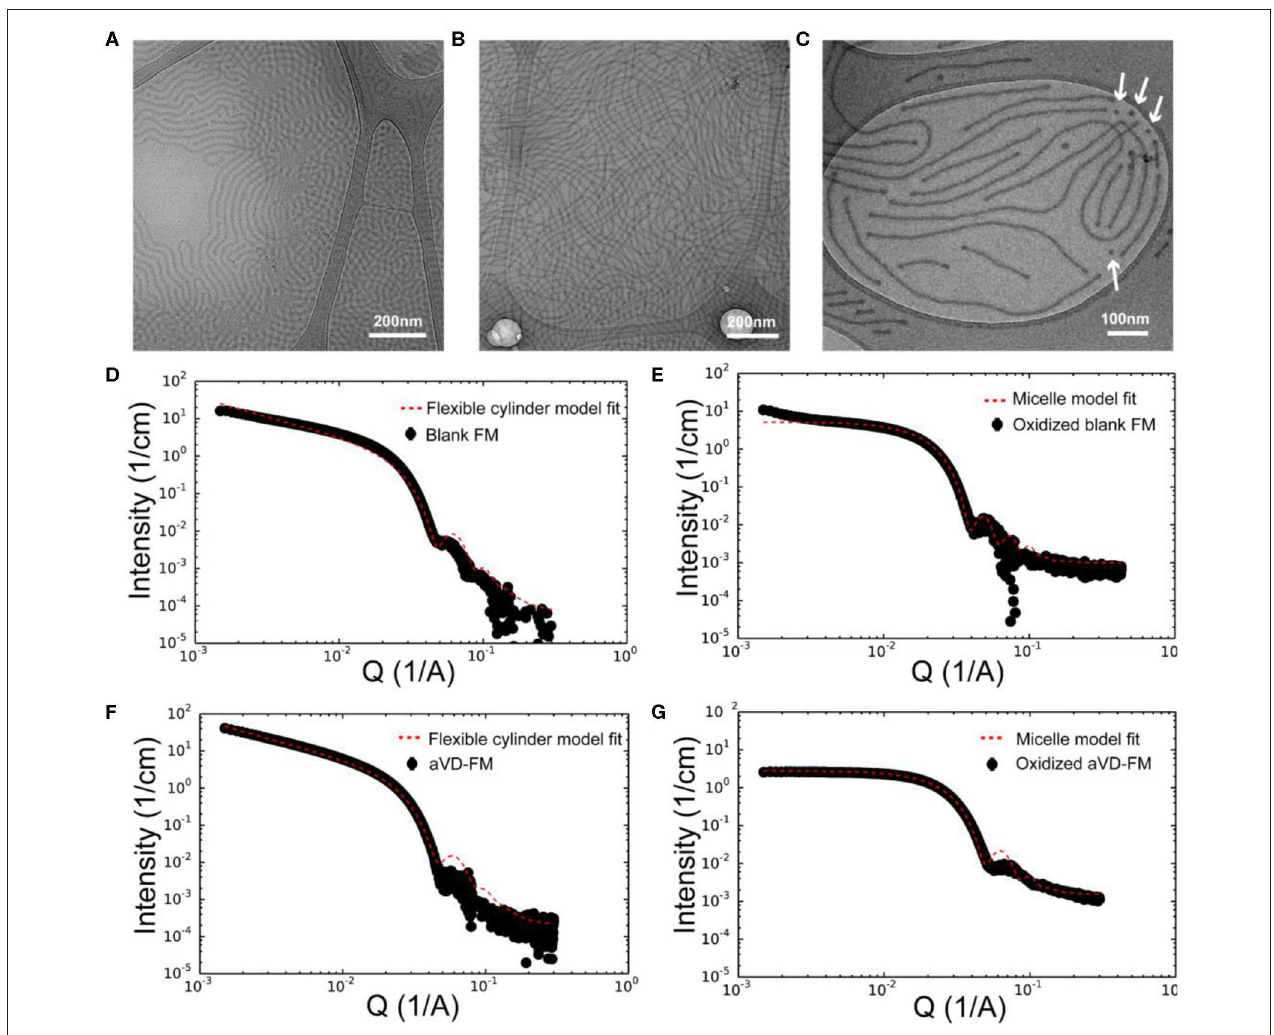
FIGURE 2 | Characterization of aVD-loaded filomicelles. CryoTEM images of filomicelles (FM) (A) and aVD-loaded FM (B,C) . The white arrows identify the morphological transition from filaments to spherical micelles. Small angle X-ray scattering (SAXS) results are shown for blank FM (D,E) and aVD-loaded FM (F,G) in PBS solution (D,F) or 500mM H 2 O 2 oxidizer (E,G)